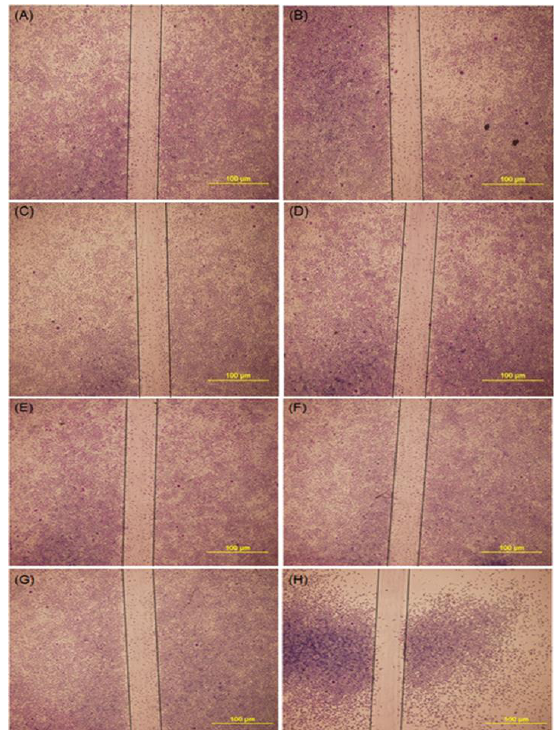
Figure 2. Optical images of L929 cells migration assay treated with various concentration of curcumin. ( A ) control ( B ) 0.00002 µ g / mL ( C ) 0.0002 µ g / mL ( D ) 0.002 µ g / mL ( E ) 0.02 µ g / mL ( F ) 0.2 µ g / mL ( G ) 2 µ g / mL ( H ) 20 µ g / mL. Scale bar is 100 µ